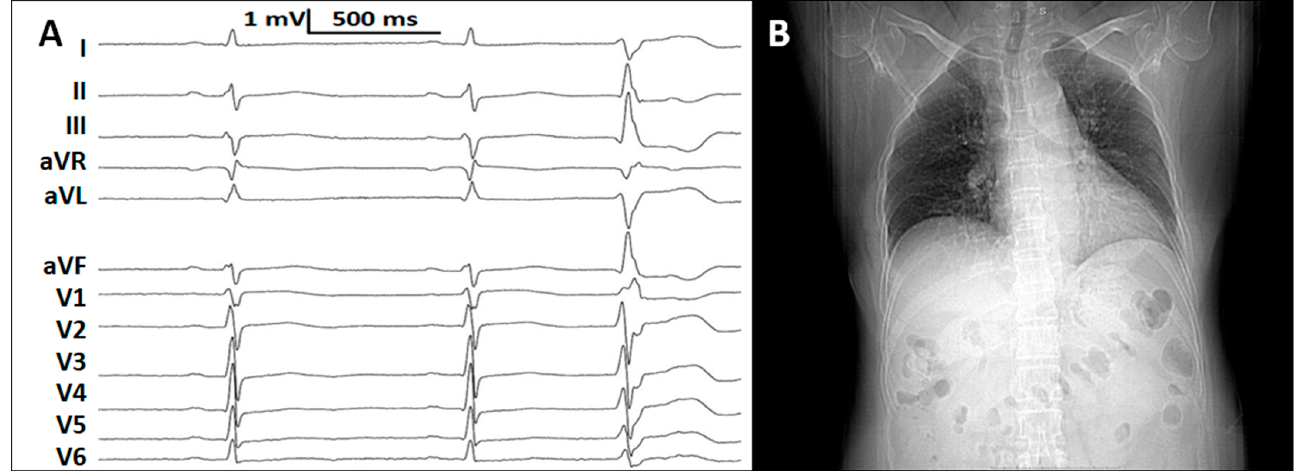
Figure 1. The ECG and chest radiograph before procedure. ( A ) A 12-lead ECG showing the normal sinus rhythm (with normal PR interval of 168 ms) and premature ventricular complexes (PVC). The QRS duration of the sinus rhythm and PVC was 97 ms and 124 ms, respectively. ( B ) Chest radiograph indicating a horizontal heart with a cardiothoracic ratio of 0.58.